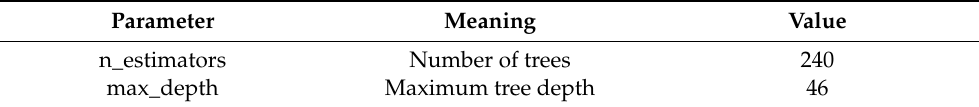
Table 2. Optimal hyperparameters of the NightPMES model. Parameter Meaning Value n_estimators Number of trees 240 max_depth Maximum tree depth